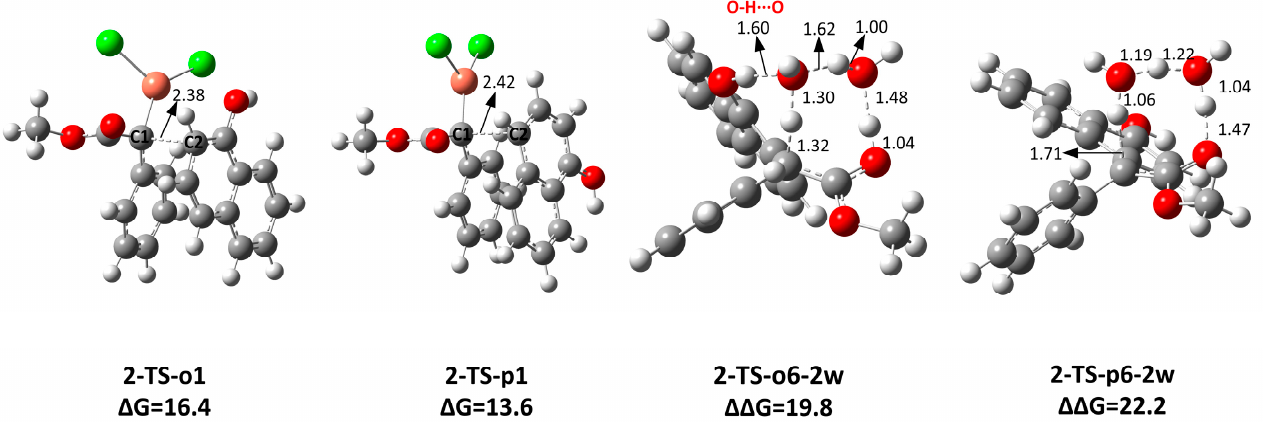
Figure 6. Optimized geometries of four transition states 2-TS-1o , 2-TS-1p , 2-TS-o6-2w , and 2-TS-6p-2w corresponding to Figure 5. The distances are in the units of angstroms and the values of free energy barriers are in kcal mol − 1 .